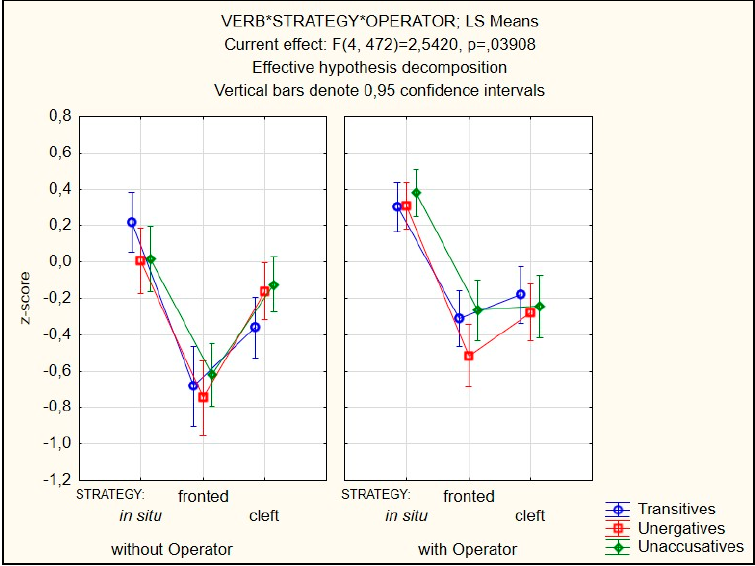
Figure 14. Three factors’ interaction (Italian).